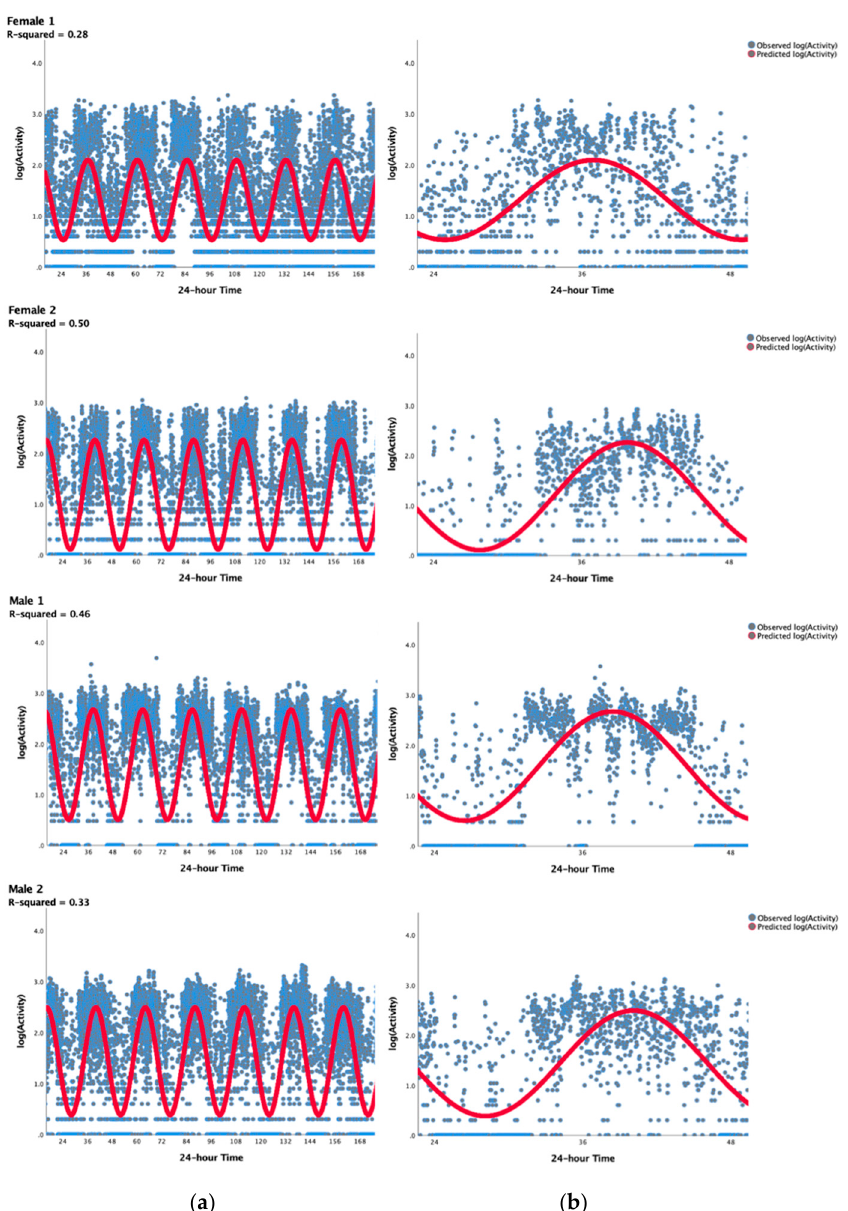
Figure 2. Example illustration of poor fit of cosinor model to observed 7-day activity data of the 4 individuals depicted in Figure 1. ( a ) Figures on the left illustrate the activity rhythm over the entire week whereas ( b ) figures on the right illustrate the overall activity pattern over a single 24 h period. As evident by both figures, the cosinor approach results in extremely poor fit of the model to observed data (mean R 2 of the entire sample = 0.35, SD =